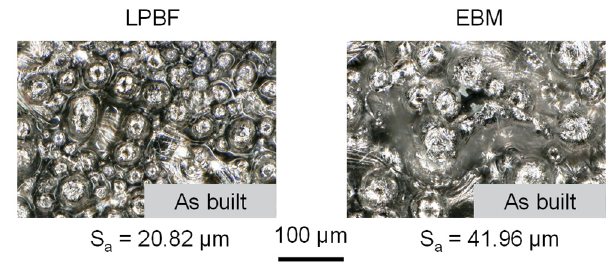
Figure 7. Distortion in overhangs depending on the overhang angle. ( a ) Visual representation of EBM overhang distortion. ( b ) EBM and LPBF distortion plotted against overhang angle.